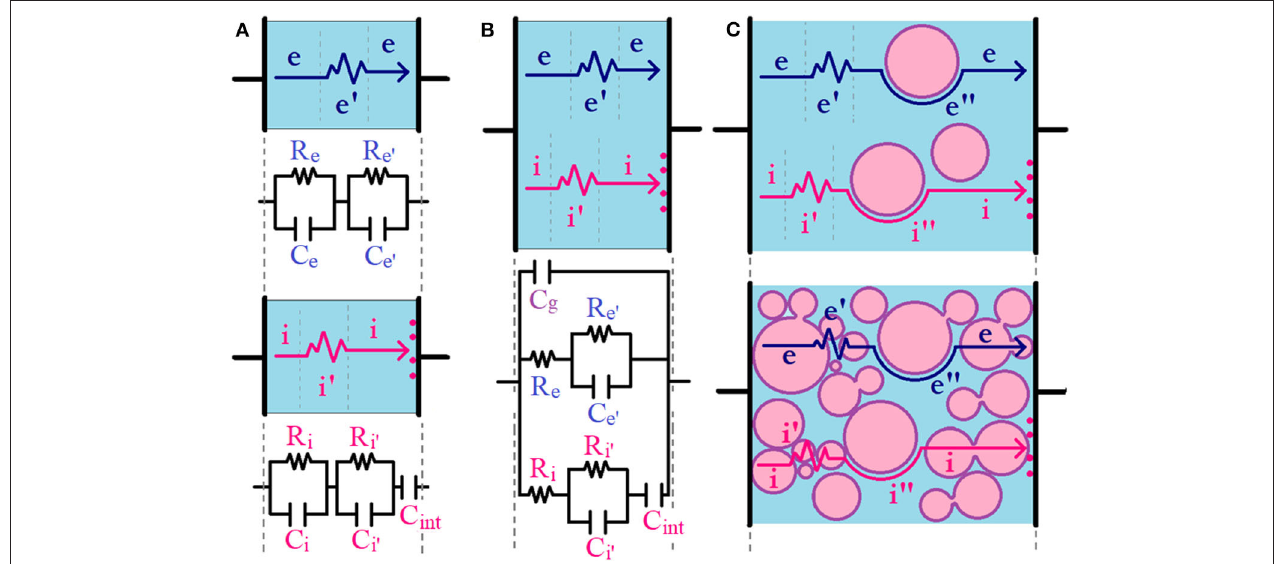
FIGURE 2 | Circuit model schematization for (A) separated electronic and ionic transport in a single phase, (B) mixed ionic–electronic transport in a single phase, and (C) mixed ionic–electronic transport in hOI -MIECs ranging from ceramic-in-polymer (upper panel) to polymer-in-ceramic (lower panel). Electronic and ionic hypothetical pathways are shown with dark blue and pink arrows. The zigzag part of the arrows indicates the presence of eventual grain boundaries or depleted regions [with associated ionic ( i ′ ) or electronic ( e ′ ) contributions] and the curved part of the arrows indicates the presence of eventual transport pathway mediated through organic–inorganic interfacial regions [with associated ionic ( i ′′ ) and electronic ( e ′′ )